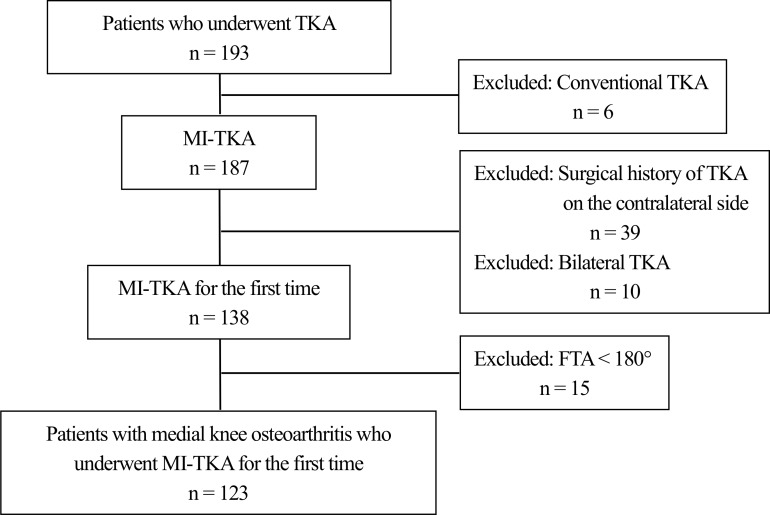
Flowchart of patients.MI-TKA, minimally invasive total knee arthroplasty; TKA, total knee arthroplasty; FTA, femorotibial angle.